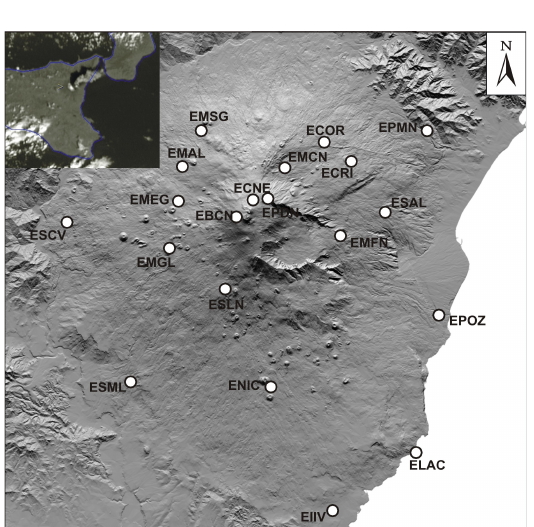
Figure 2: Map of GPS sites with underlying digital elev- ation model of Etna. Inset, the EUMETSAT Meteosat images of the 23 November 2013 plume at 10:15 GMT The SNR data with higher elevation angle were used for plume sensing, excluding data below 30° because of their oscillations caused by ground reflections. The repeatability of the SNR data during the six days across the lava fountain event is similar to the black line in Figure 1. In order to examine and assess the potential to improve the Larson [2013] method, take account of all available satellite tracks, avoid data shift and obtain the same satellite geometry (sidereal day), we used the whole data set of seven days. During the three days before and after the event, we assume that no anomaly disrupted the SNR-L2 signal. Hence, for each receiver-satellite pair, the best fitting curve of the SNR-L2 (elevation) data was com- puted. This curve represents the SNR-L2 mod- el as a function of the elevation angle and